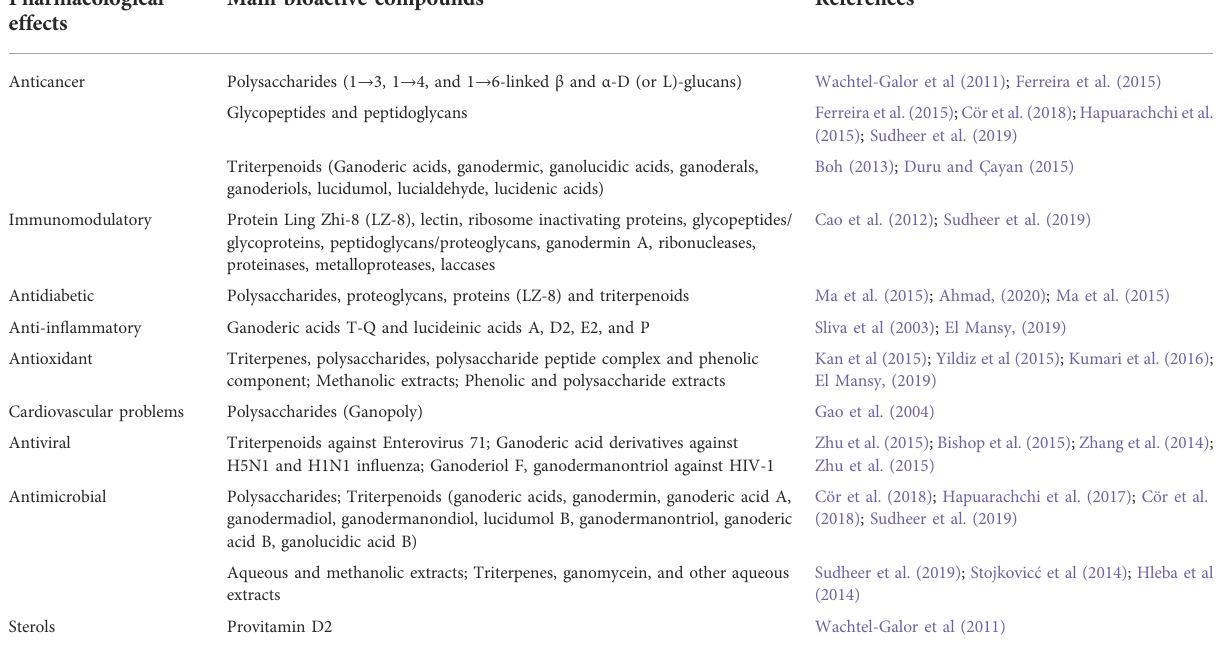
TABLE 2 Common pharmacological effects of G. lucidum main bioactive